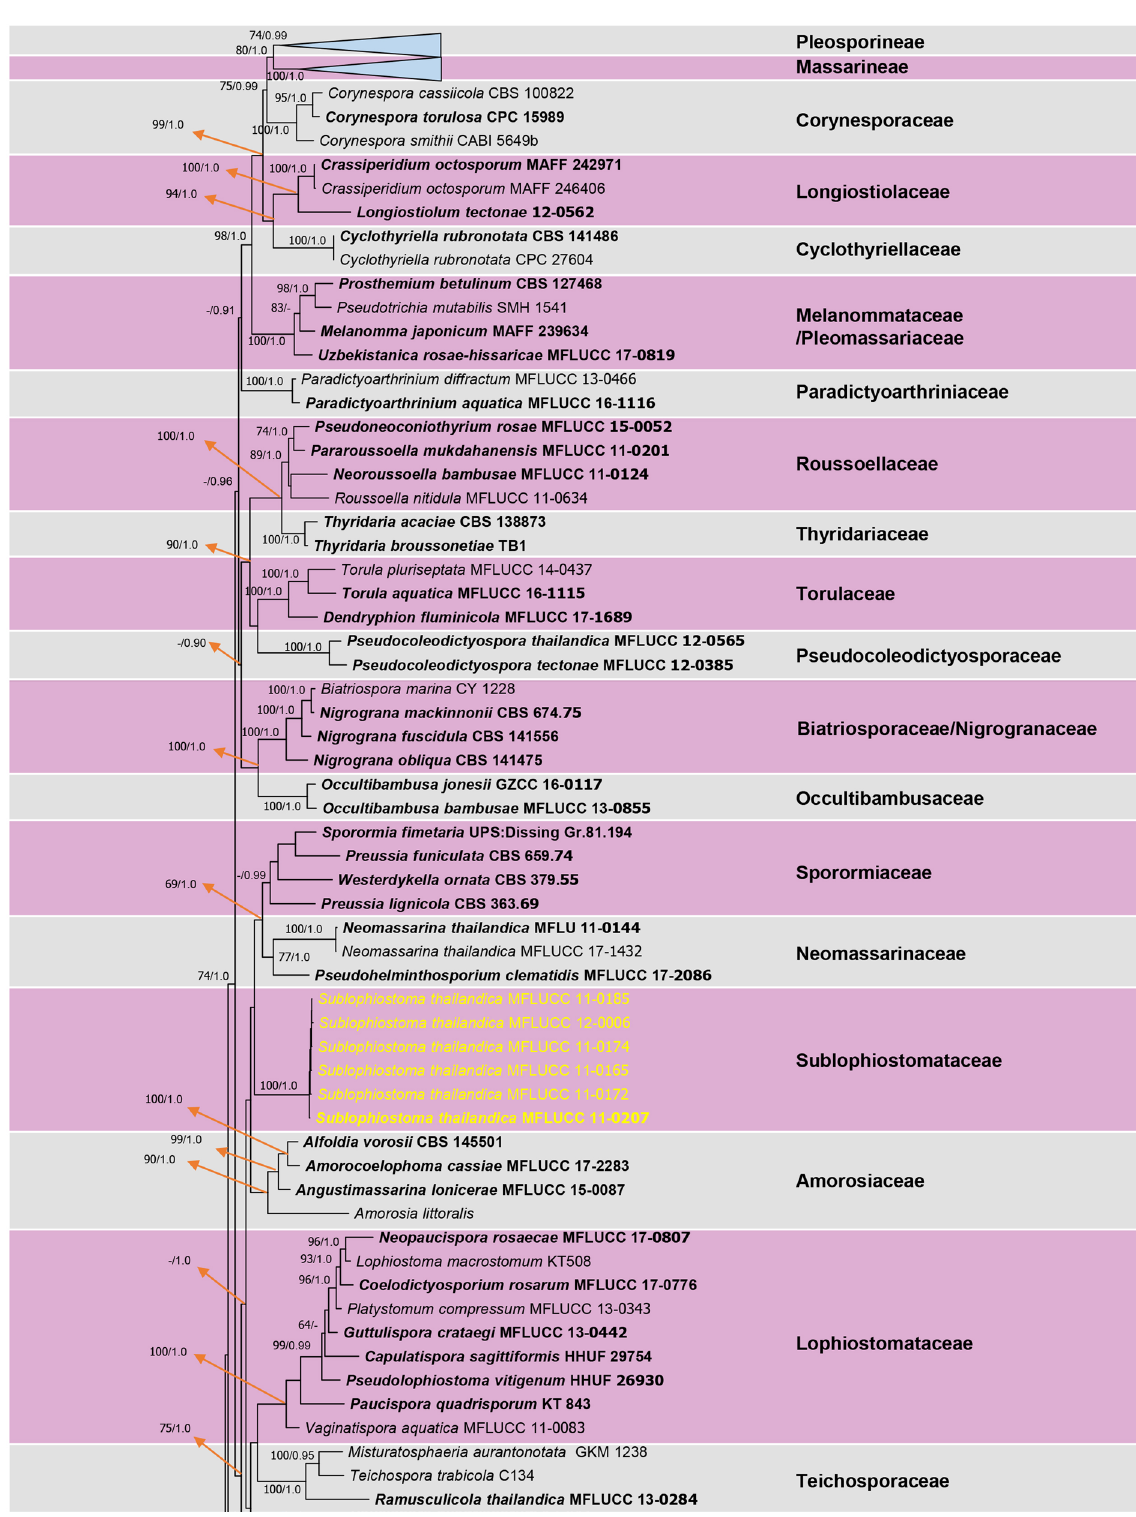
Figure 1. Resulting phylogram of maximum-likelihood analysis based on a combined ITS, LSU, RPB2, SSU and TEF sequence data. Maximum likelihood bootstrap support values (ML) equal or higher than 60% and Bayesian probability values (BYPP) equal to or above 0.90 are given at the nodes (ML/ BYPP). The tree is rooted to Capnodium coffeae (CBS 147.52). Newly introduced strains are indicated in yellow and ex-type strains in